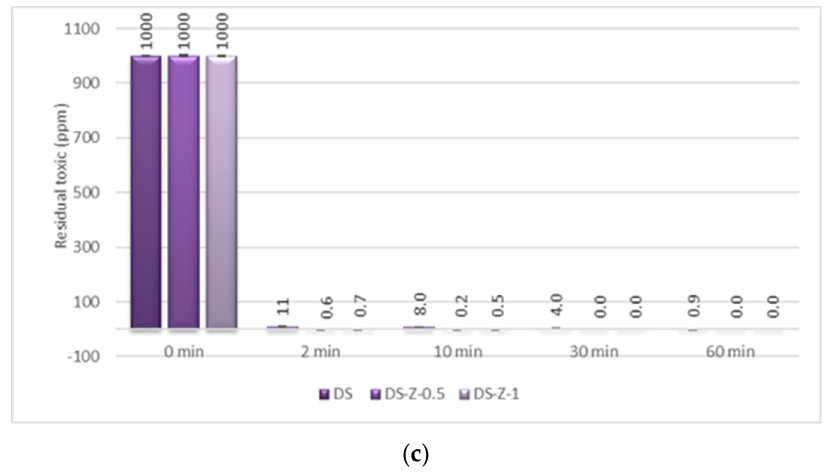
Figure 12. Residual soman after employing decontamination formulations based on ( a ) ZnO, ( b ) TiO 2 , and ( c ) zeolite (detailed statistical data presented in Tables S9 and S10—Supplementary Material File).